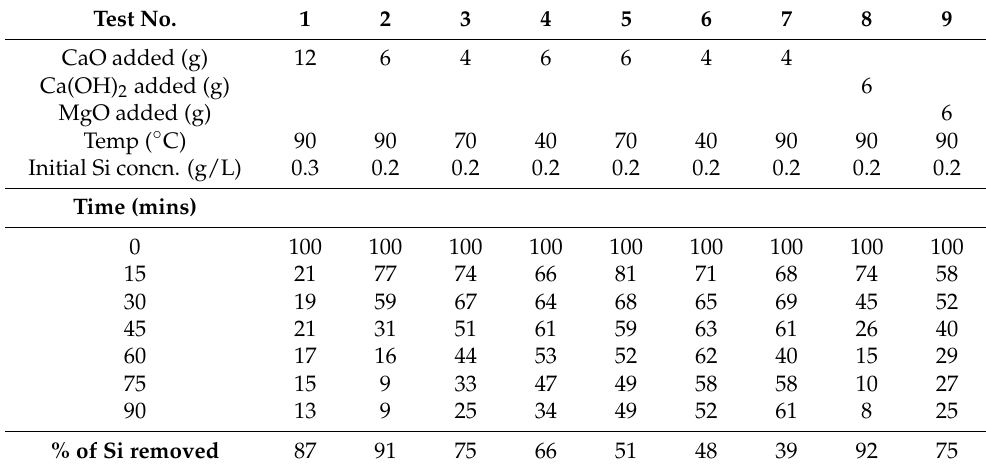
Table 2. The desilication conditions and percentage reduction of Si with time. Test No.